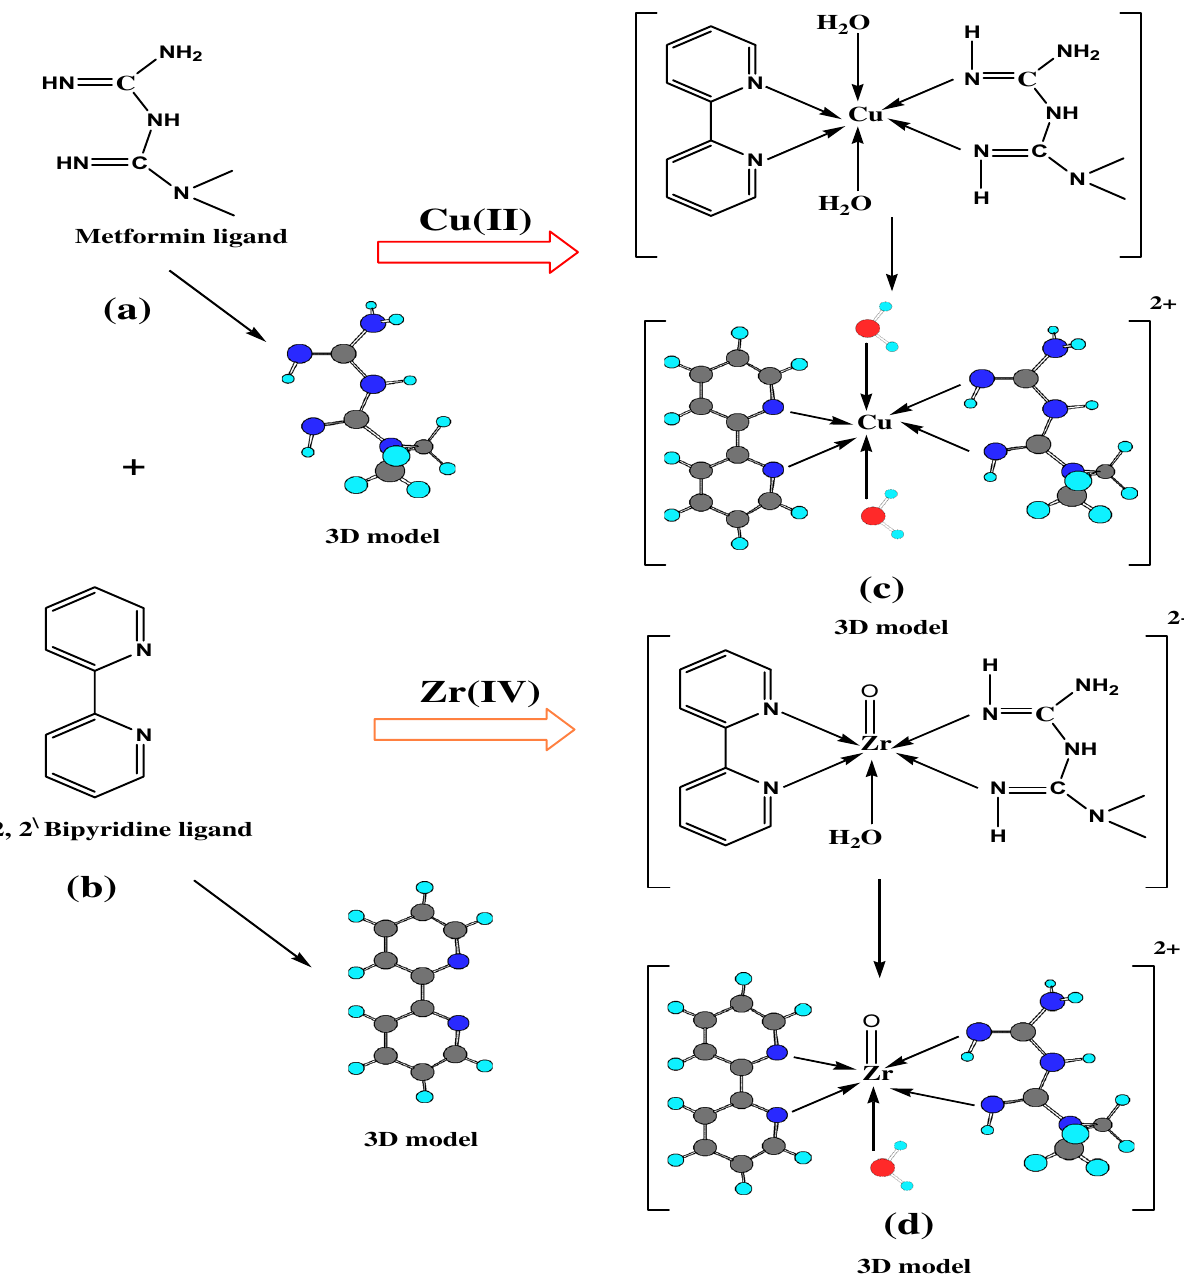
Figure 1. Molecular structures of ( a ) MF, ( b ) Bipy, ( c ) Cu(II) and ( d ) Zr(IV) and their 3D models.